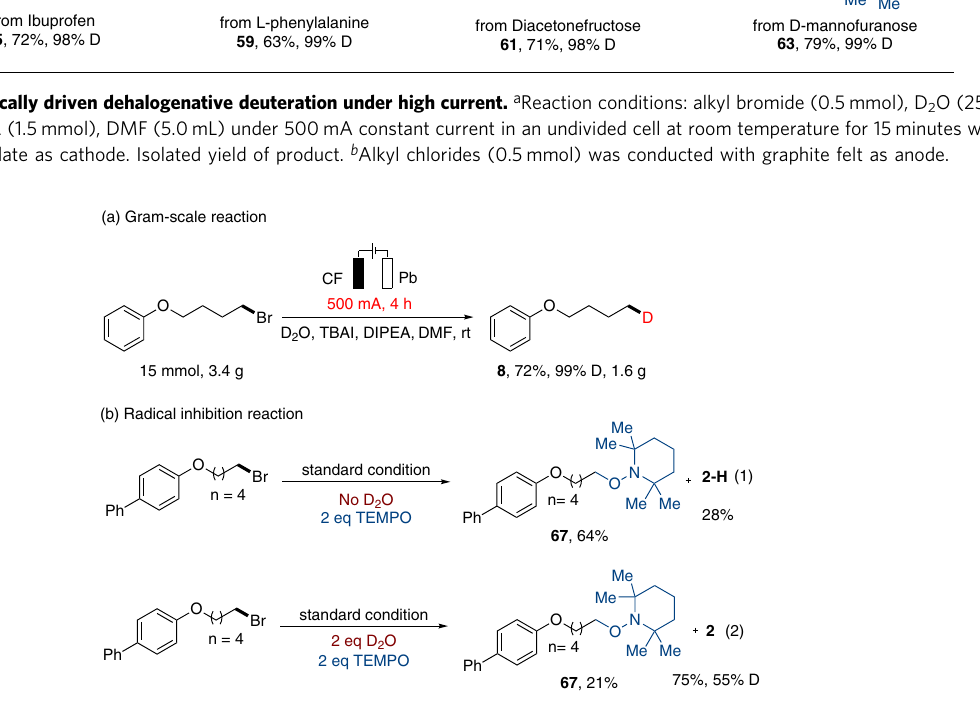
Fig. 4 Gram-scale reaction and mechanistic studies. a The compound 8 could be prepared in gram-scale with higher isolated yield. Gram-scale reaction. b Radical inhibition reaction was performed, indicating that the alkyl radical might be